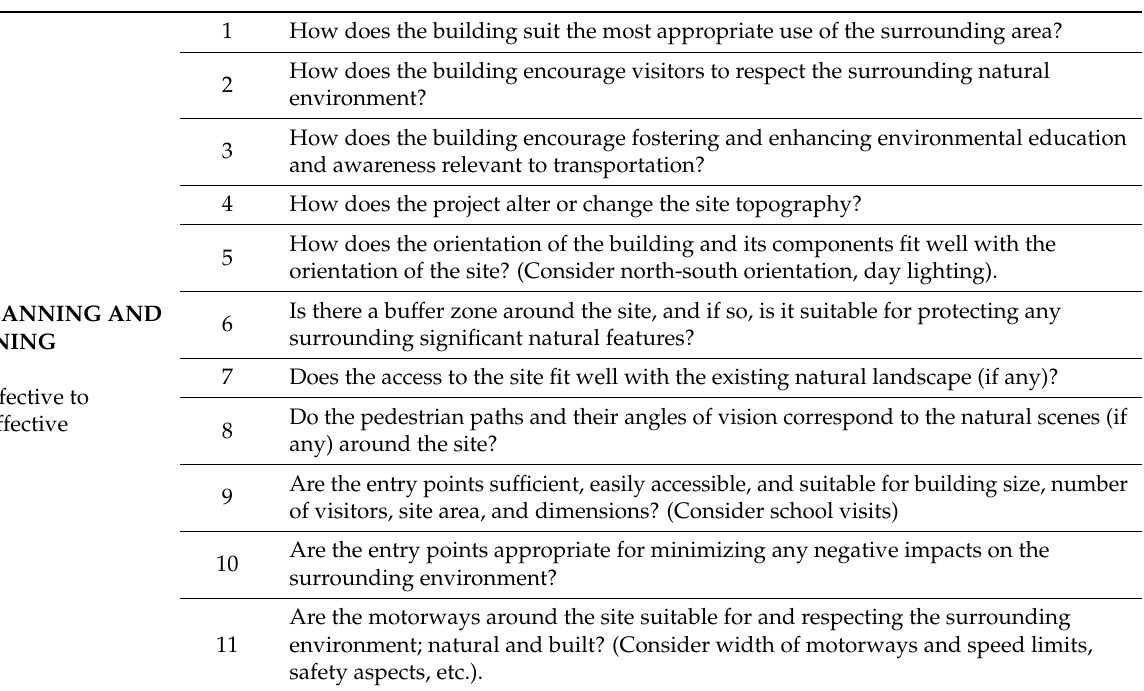
Table 1. Checklist utilized in the Walking Tour Assessment procedure: 33 questions were scored using a 6-point Likert scale. (Some aspects of the tool have been utilized in other publications by the authors